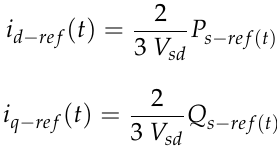
I q − − Figure 8. Simplified current control loop in dq frame. As a result, the loop gain of the simplified loop will be given as follows: